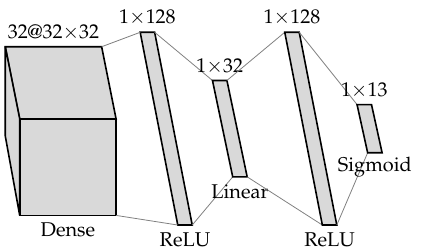
Figure 9. DNN topology for the Sydney Urban Objects Dataset